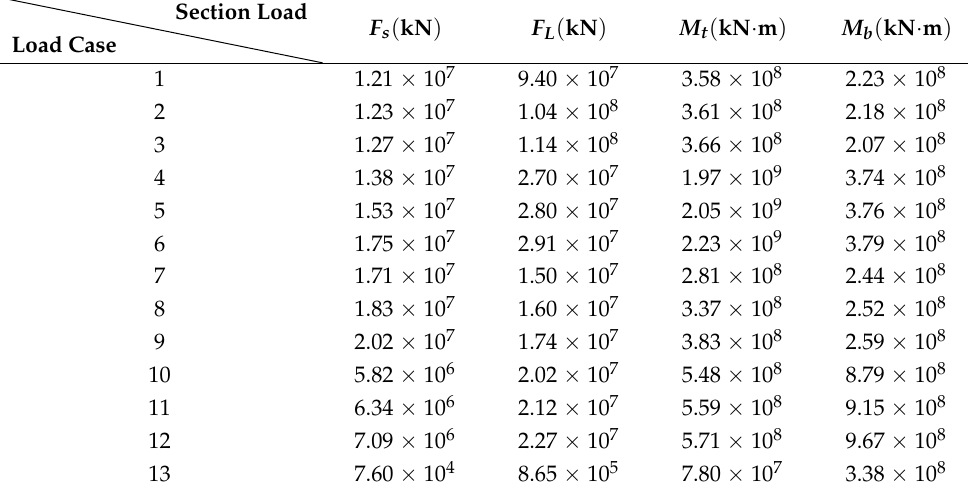
Table 6. Calculation results of the main section loads of the